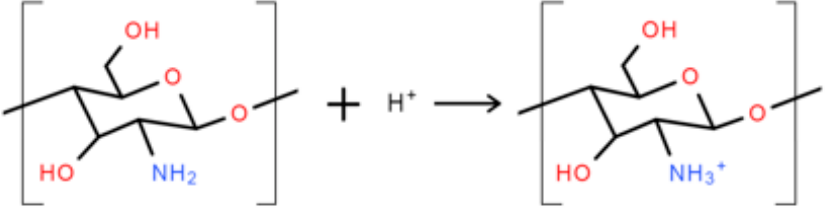
Figure 9. Schematic illustration of the protonation of amine groups in low-pH aqueous